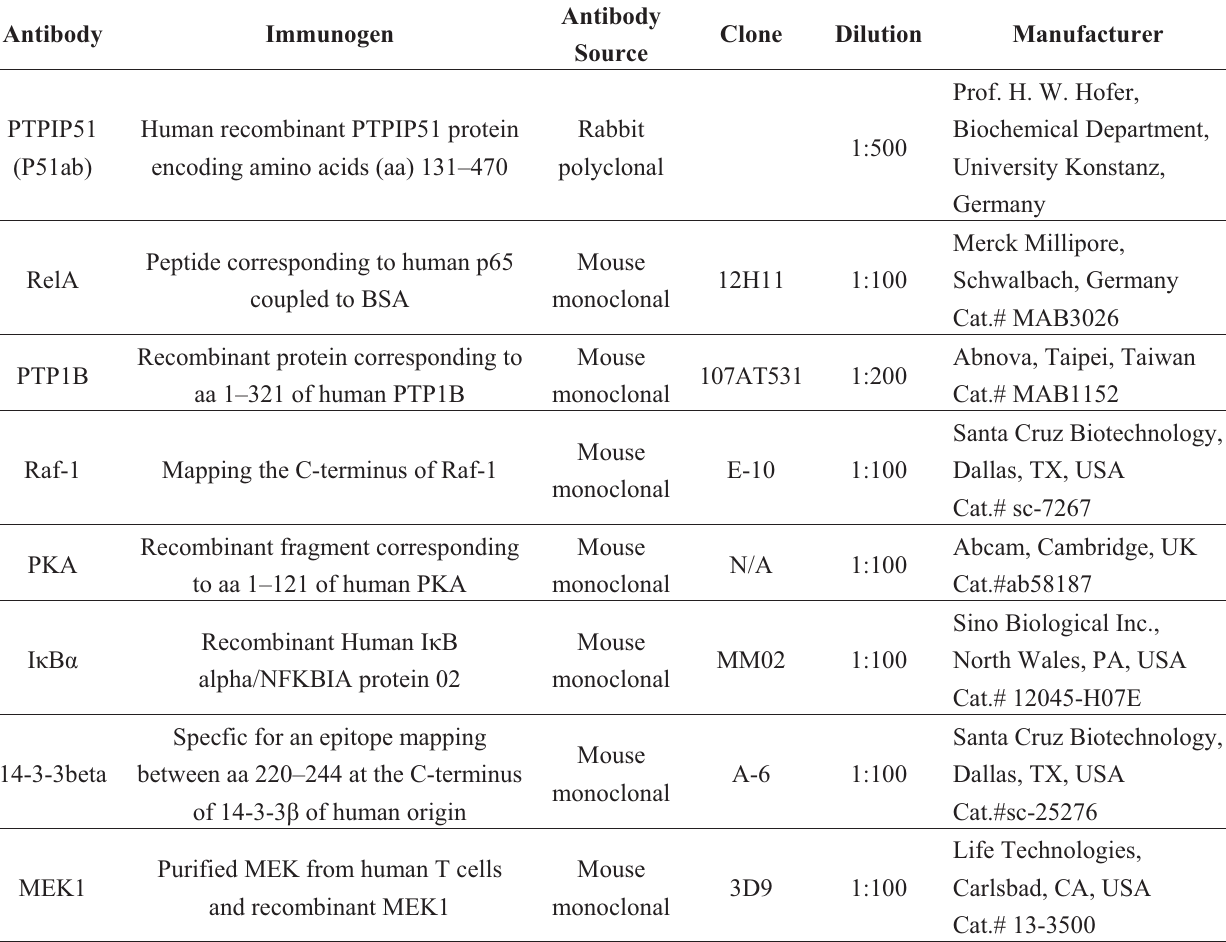
Table 1. List of antibodies used for the immunocytochemistry and DPLA. Antibody Immunogen